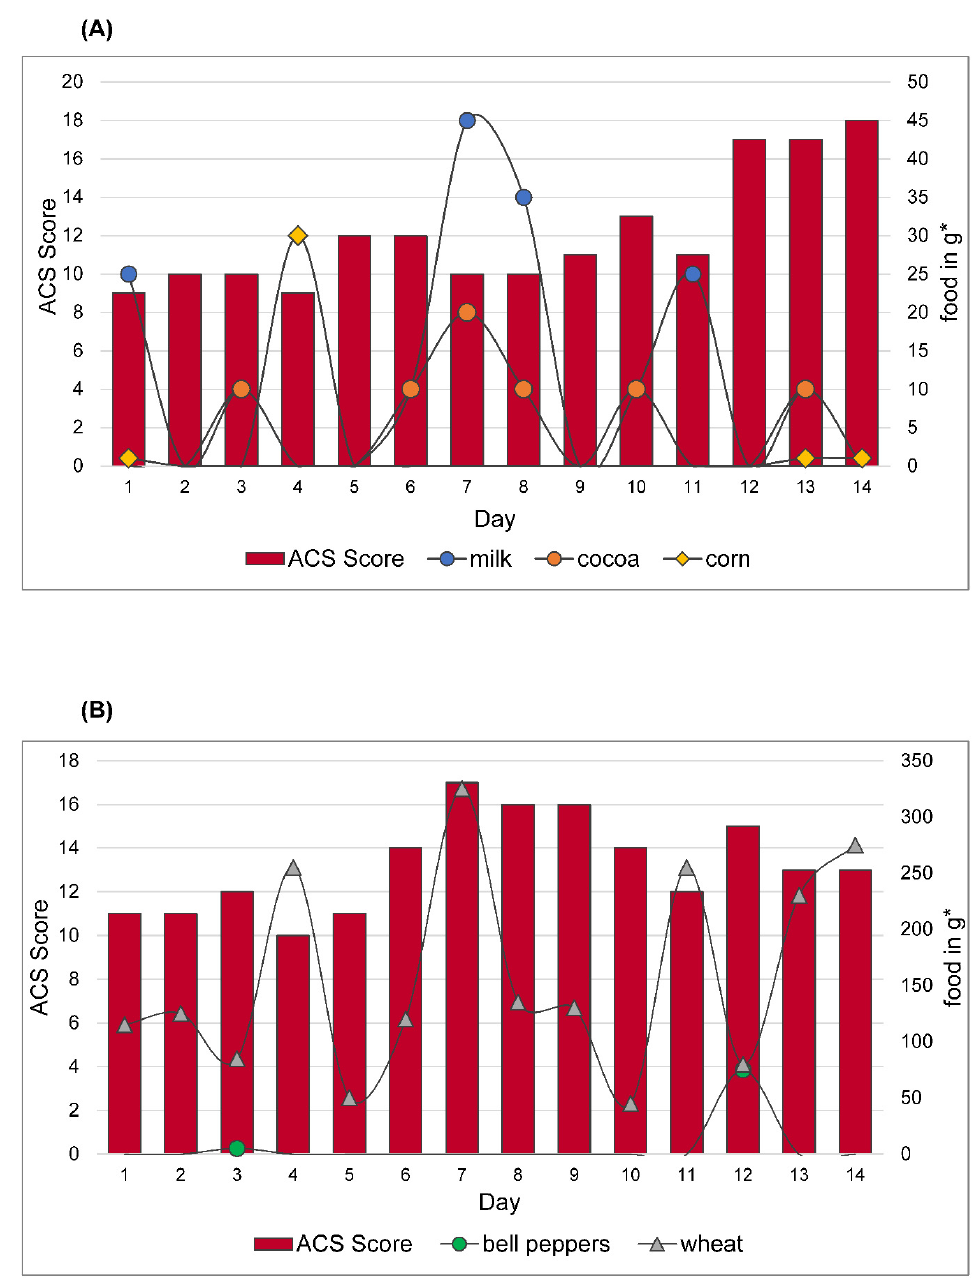
Figure 7. ( A ) Food sensitivity of participant 1. Reactions to different foods in the pre-diet phase. Food sensitivities safely detected during the reintroduction phase: milk, cocoa, peanut and corn. Peanuts are not mentioned because they were not eaten in the pre-diet phase. ( B ) Food sensitivity of participant 2. Reactions to different foods in the pre-diet phase. Food sensitivities safely detected during the reintroduction phase: bell peppers and wheat. ACS value declared by parents, displayed in red bars on the left axis. Amount of intolerable food consumed in grams * shown in lines on the right axis. * estimated amount.